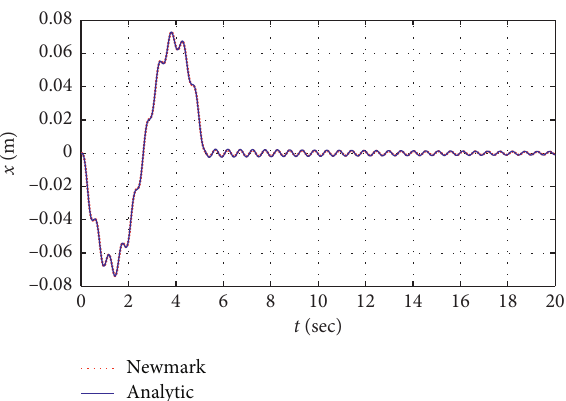
Figure 7: Response of the beam with the Newmark and analytical methods for ξ � 0 . 4% and ω � 1.2